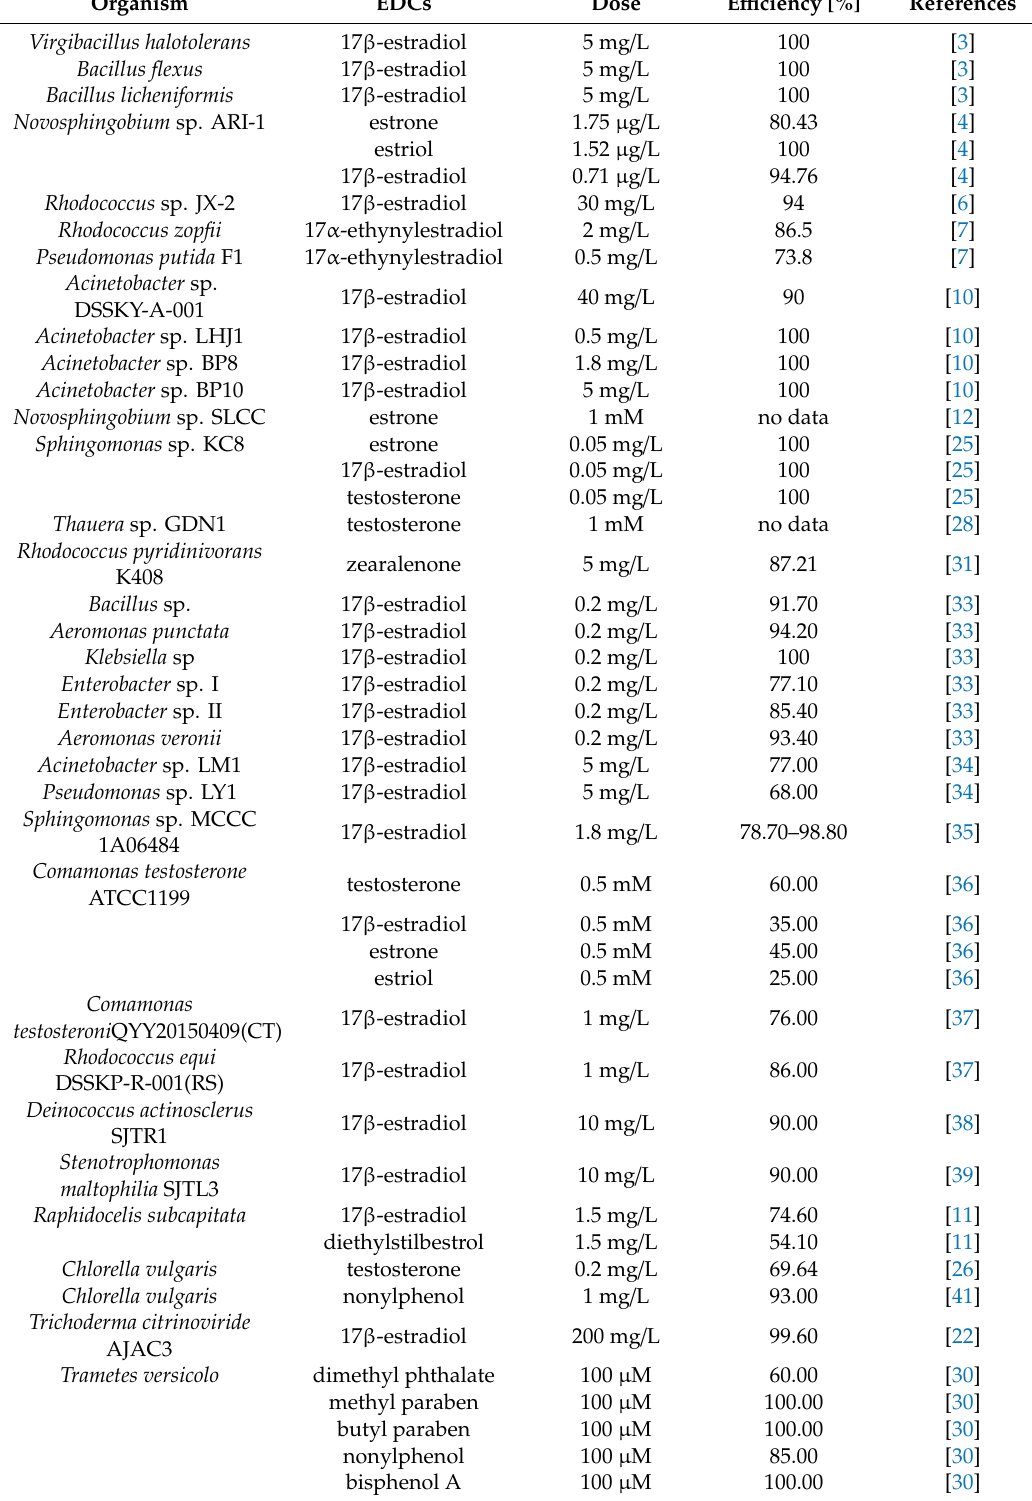
Table 2. Microorganisms engaged in EDCs biodegradation / biotransformation. Organism EDCs